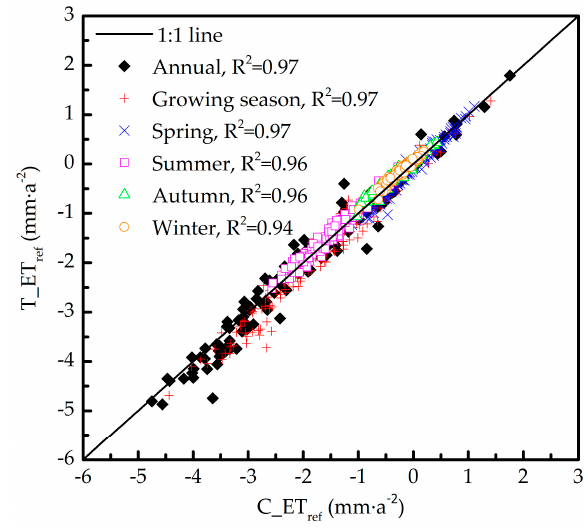
Figure 7. Relationship between the calculated C_ET ref and the estimated ET ref trend ( T_ET ref ) by Theil–Sen’s estimator.